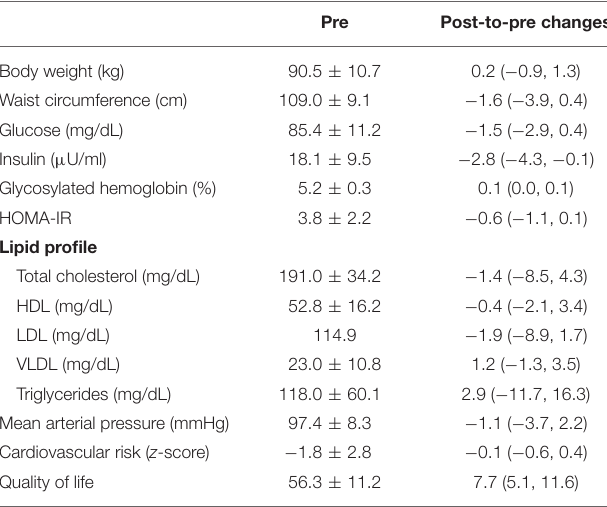
TABLE 2 | Associations between changes in body weight (predictor variable) and waist circumference, cardiovascular risk factors, clustered cardiometabolic risk, and quality of